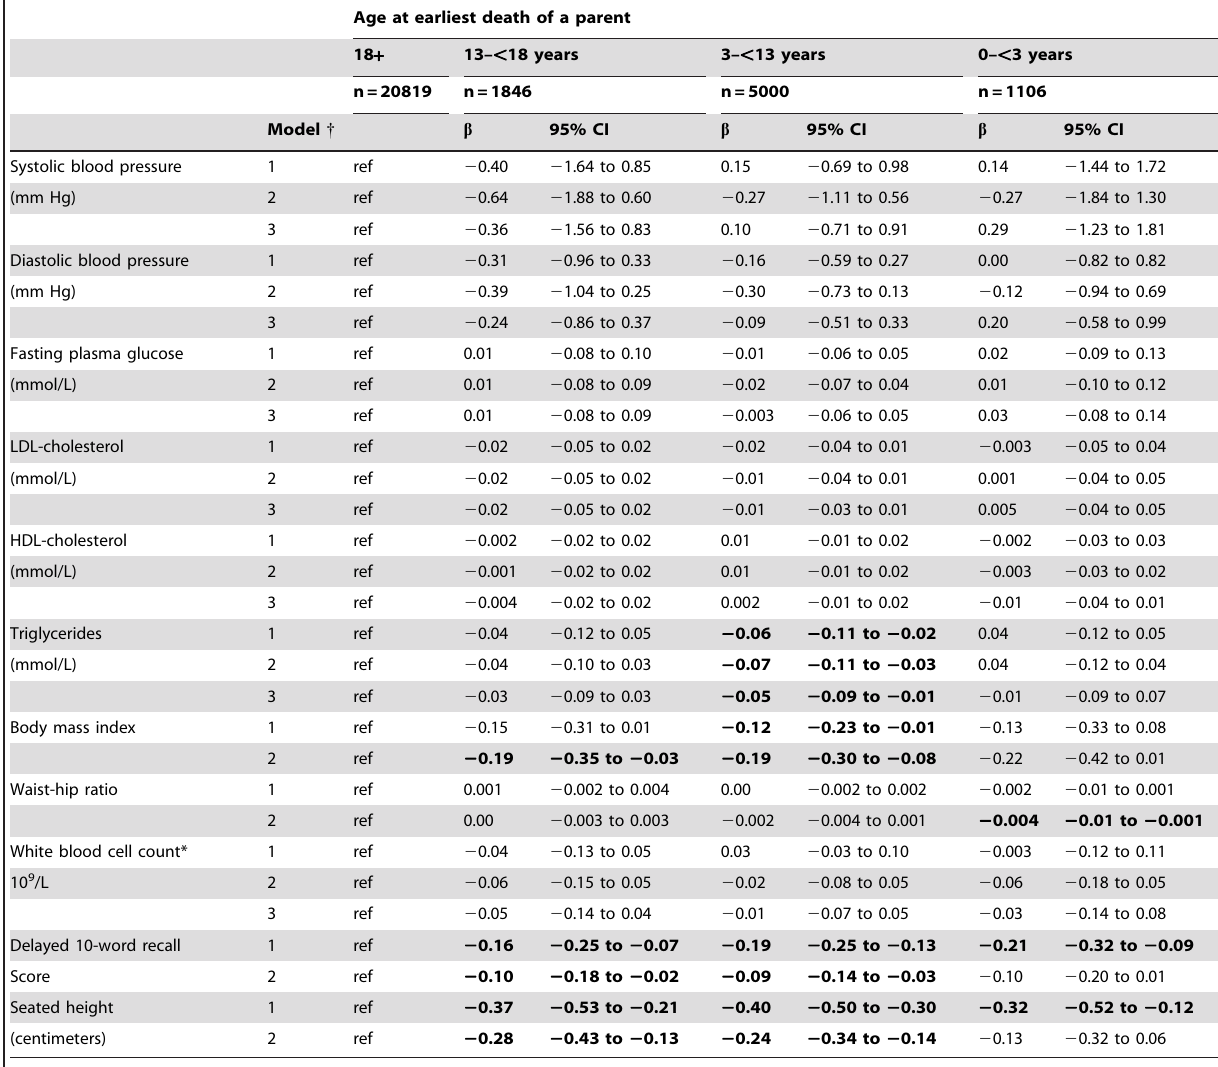
Table 4. Adjusted associations of age at earliest death of a parent with cardiovascular risk factors, seated height and delayed 10- word recall score in 28,771 older Chinese men and women in recruitment phases 1, 2 and 3 of The Guangzhou Biobank Cohort Study